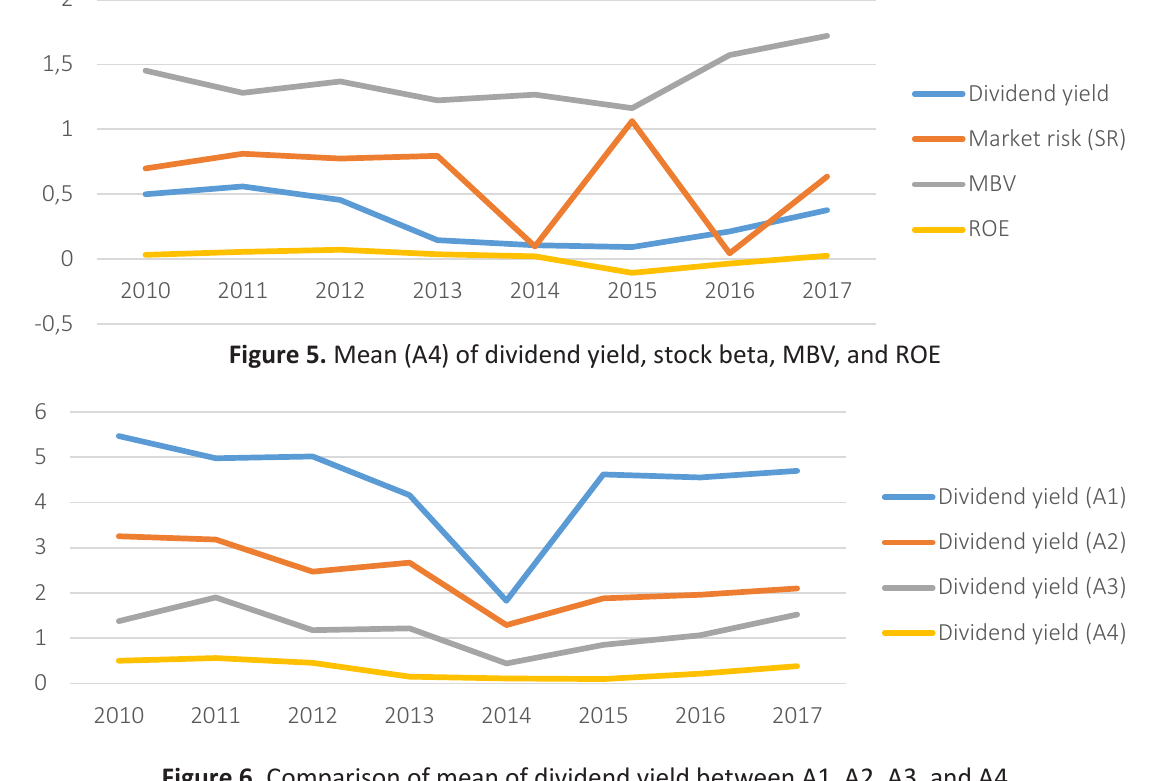
Figure 6. Comparison of mean of dividend yield between A1, A2, A3, and A4